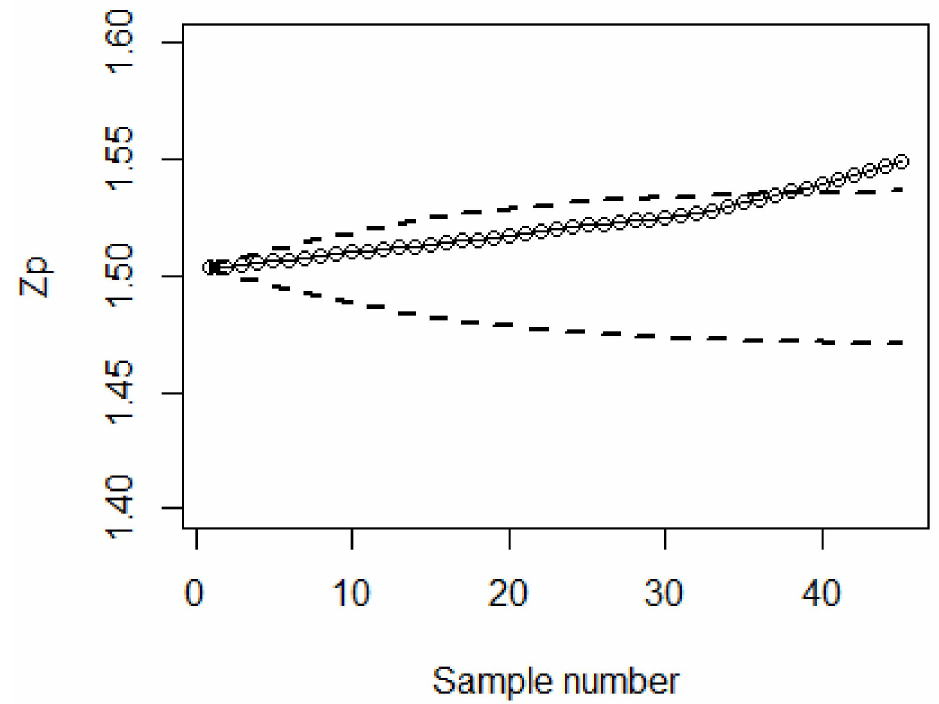
Figure 3. Bayesian HEWMA control chart using posterior and posterior predictive distribution under SELF for RSS.